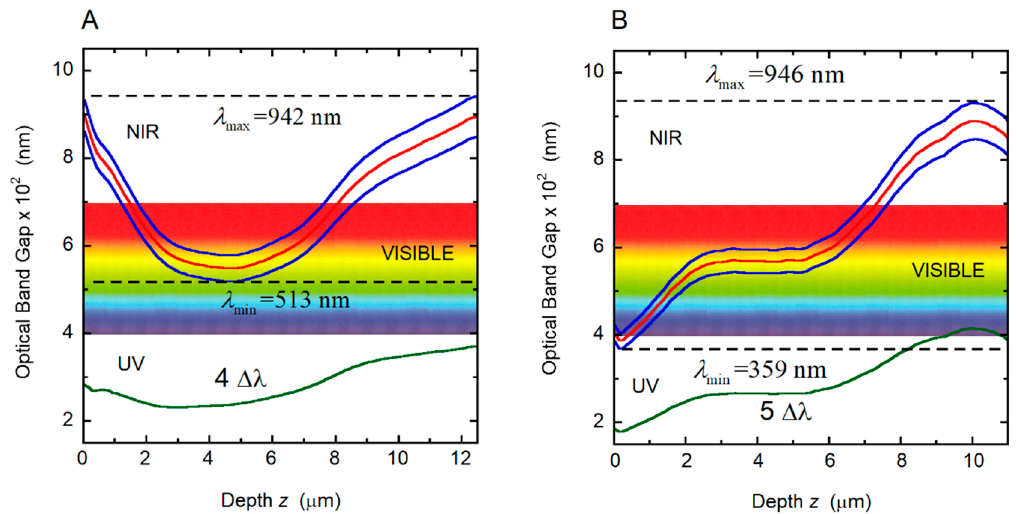
Figure 12. Variation with depth through the cuticle of the local photonic band gap ( ∆ λ ( z )) and of its limits ( λ + ( z ) and λ − ( z ), solid blue lines), for the two photonic crystals considered and correlated with the cuticles of ( A ) golden C. chrysargyrea and ( B ) silvery C. chrysargyrea scarabs whose calculated reflection spectra are displayed in Figure 11. The red line indicates the central position of the photonic band gap, λ o . NIR: Near infrared; UV: Ultraviolet.